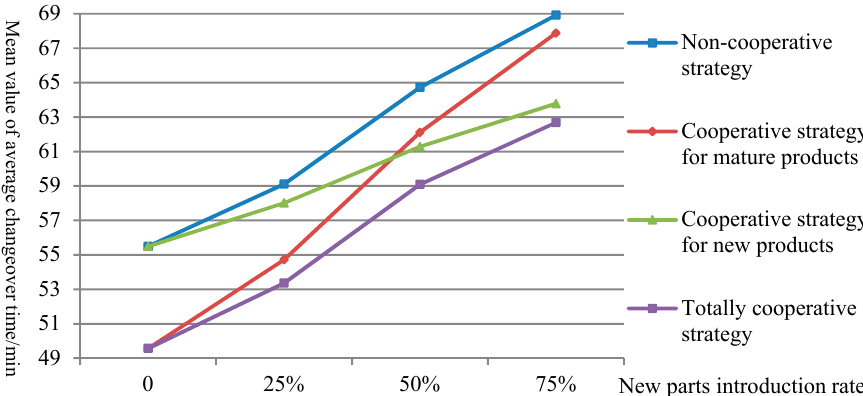
Figure 6. Mean values of average changeover time under different conditions.